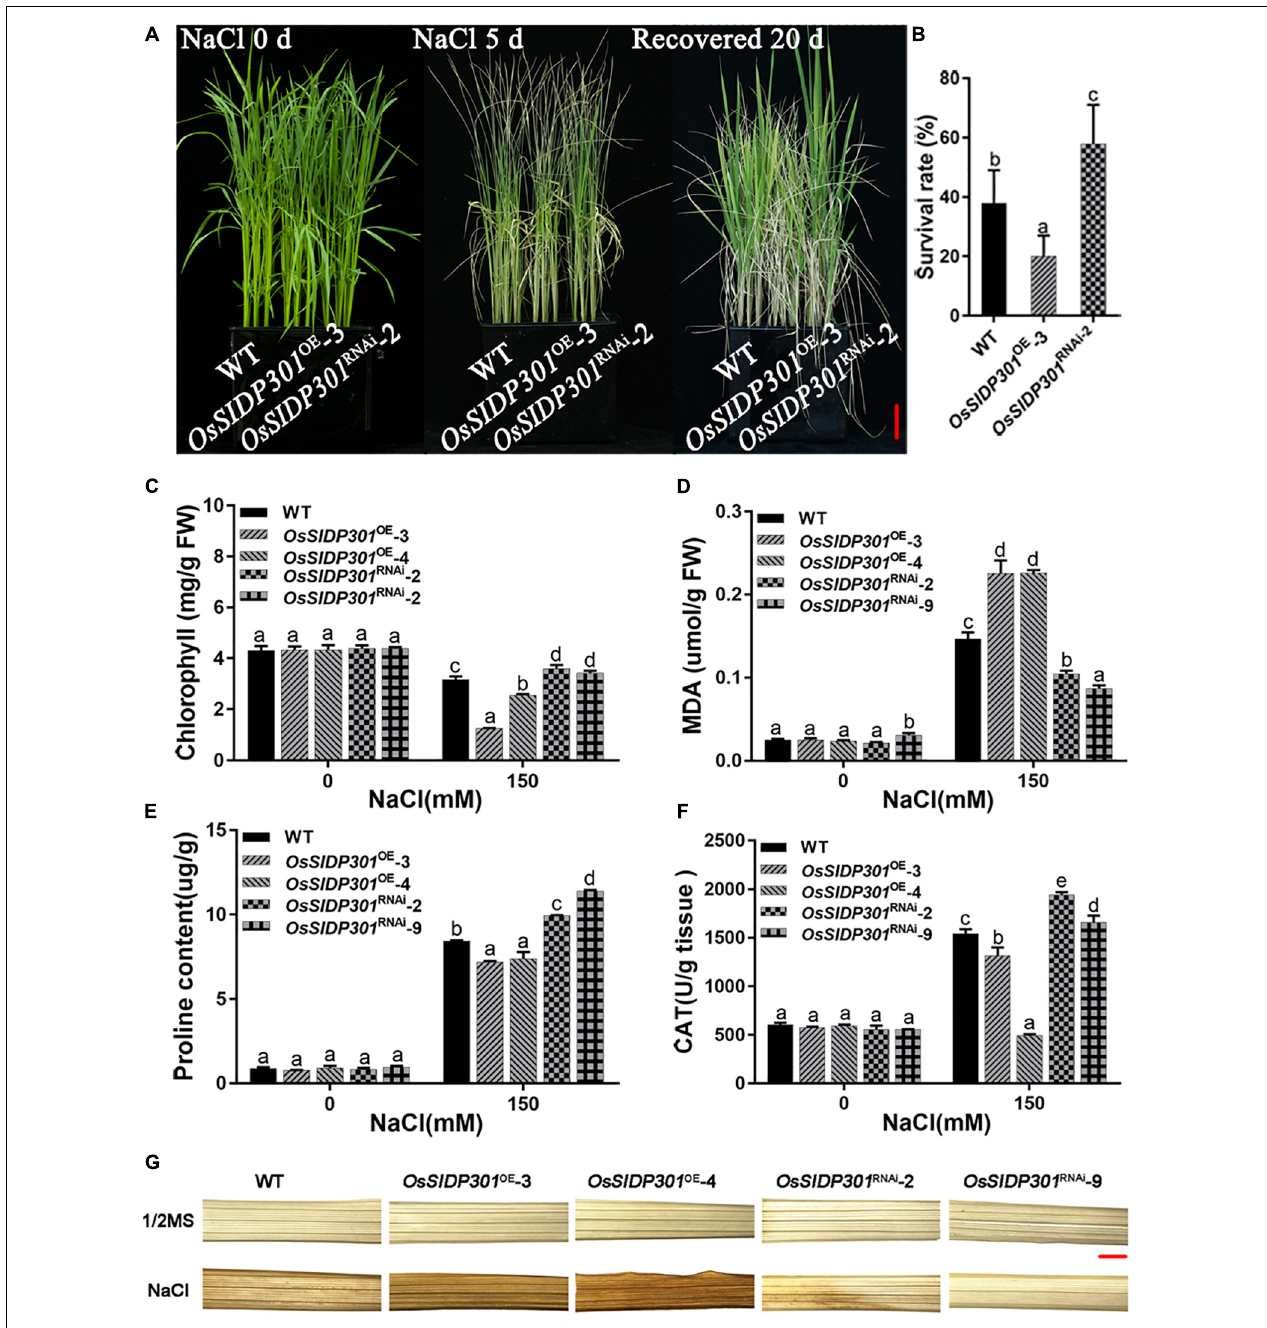
FIGURE 3 | Physiological changes in OsSIDP301 transgenic plants. (A) Phenotype of OsSIDP301 transgenic plants that were treated with 150 mM NaCl solution for 5 days and then recovered for 20 days, bar = 3 cm. (B) Survival rate of the panel (A) . (C) The chlorophyll content of 3-week-old plant leaves with or without 150 mM NaCl treatment. (D) The MDA content of 3-week-old plant leaves with or without 150 mM NaCl treatment. (E) The proline content of 3-week-old plant leaves with or without 150 mM NaCl treatment. (F) The CAT activity of 3-week-old plant leaves with or without 150 mM NaCl treatment. (G) The DAB staining of 3-week-old plant leaves with or without 150 mM NaCl treatment, bar = 1 mm. Data are shown as mean ± SD ( n = 3), different letters suggested significant differences at P < 0.05.